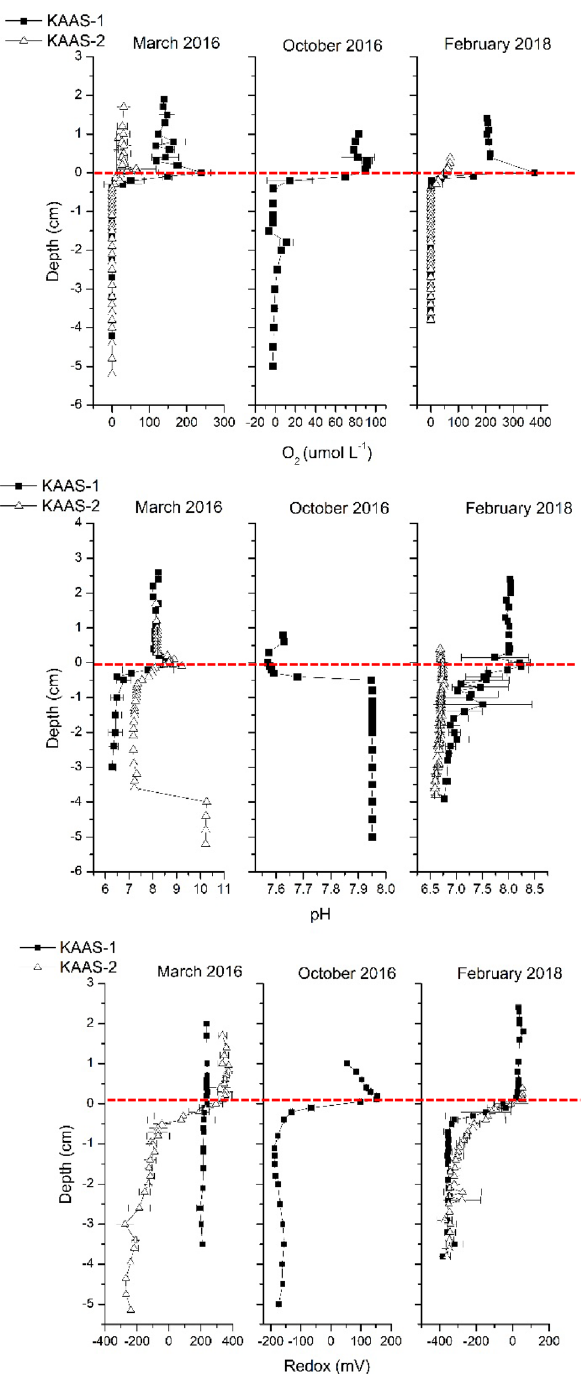
Figure 2. [Top]: Vertical microsensor profiles oxygen [μmol L −1 ] from KAAS-1 and KAAS-2 from March and October 2016, as well as February 2018. [Middle]: Vertical microsensor profiles of pH from KAAS-1 and KAAS-2 from March and October 2016, as well as February 2018. [Bottom]: Vertical microsensor profiles of redox [mV] from KAAS-1 and KAAS-2 from March and October 2016, as well as February